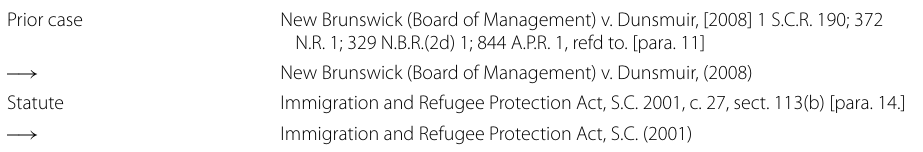
Table 1 An example of reference identification within legal cases Prior